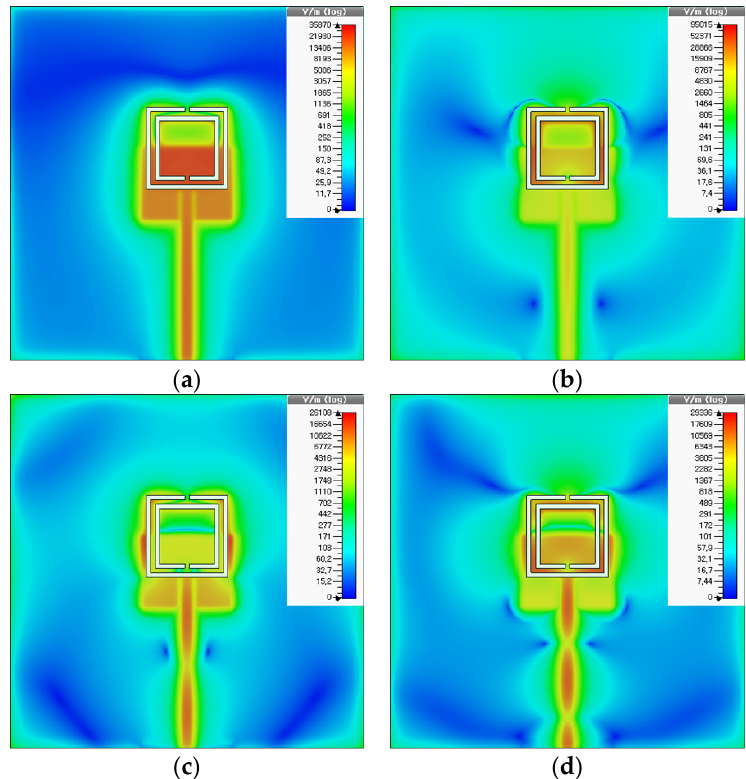
Figure 6. Electric field distributions on the ground plane at the first four resonant frequencies of the proposed scaled DR-CSRR-RA DGS-loaded MPSA: ( a ) 0.808 GHz; ( b ) 2.5 GHz; ( c ) 4.09 GHz; and ( d ) 5.318 GHz.